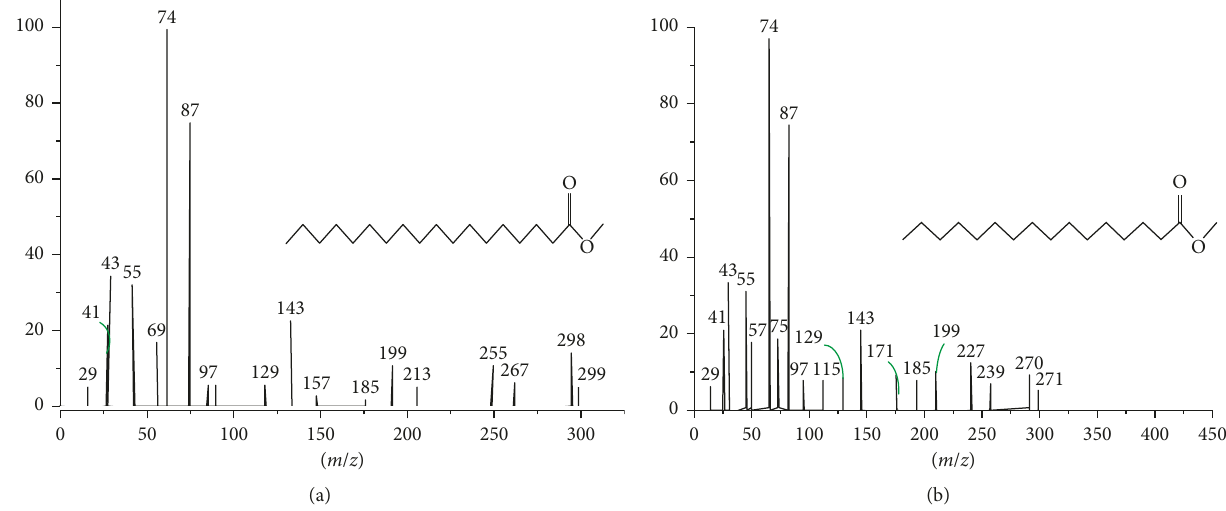
Figure 5: Spectrum evaluated by gas chromatography and mass (GC-MS) of the biosurfactant of Cunninghamella echinulata : pre- dominance of stearic acid (a) with mass of 298m/z and pentadecyl acid with mass of 270m/z (b) in the hydrophobic